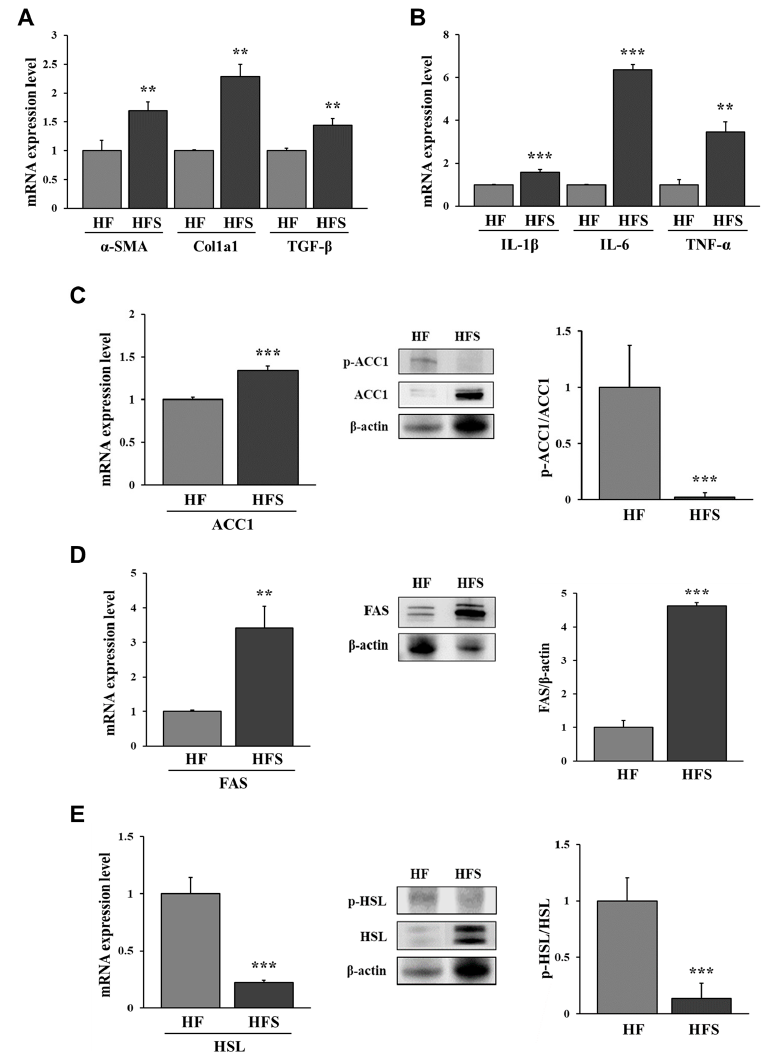
Figure 2. Relative mRNA expression of fibrotic factors α -SMA, Col1a1, and TGF- β ( A ) and pro- inflammatory cytokines IL-1 β , IL-6, and TNF- α ( B ) and relative mRNA and protein expression of ACC1 ( C ), FAS ( D ), and HSL ( E ) in the livers of mice. C57BL/6J mice were fed a high-fat diet (HF; AIN-93G with 60 kcal% fat) or a high-fat diet with 10% sucrose water (HFS) for 12 weeks. All data are expressed as the mean ± standard deviation. Statistical analyses were performed using Student’s t -test ( n = 3, HF vs. HFS; **, p < 0.01, ***, p < 0.001). α -SMA, alpha-smooth muscle actin; Col1a1, collagen type 1 alpha 1; TGF- β , transforming growth factor-beta; IL-1 β , interleukin-1 beta; IL-6, interleukin-6; TNF- α , tumor necrosis factor-alpha; ACC1, acetyl-CoA carboxylase 1; FAS, fatty acid synthase; HSL, hormone-sensitive lipase.